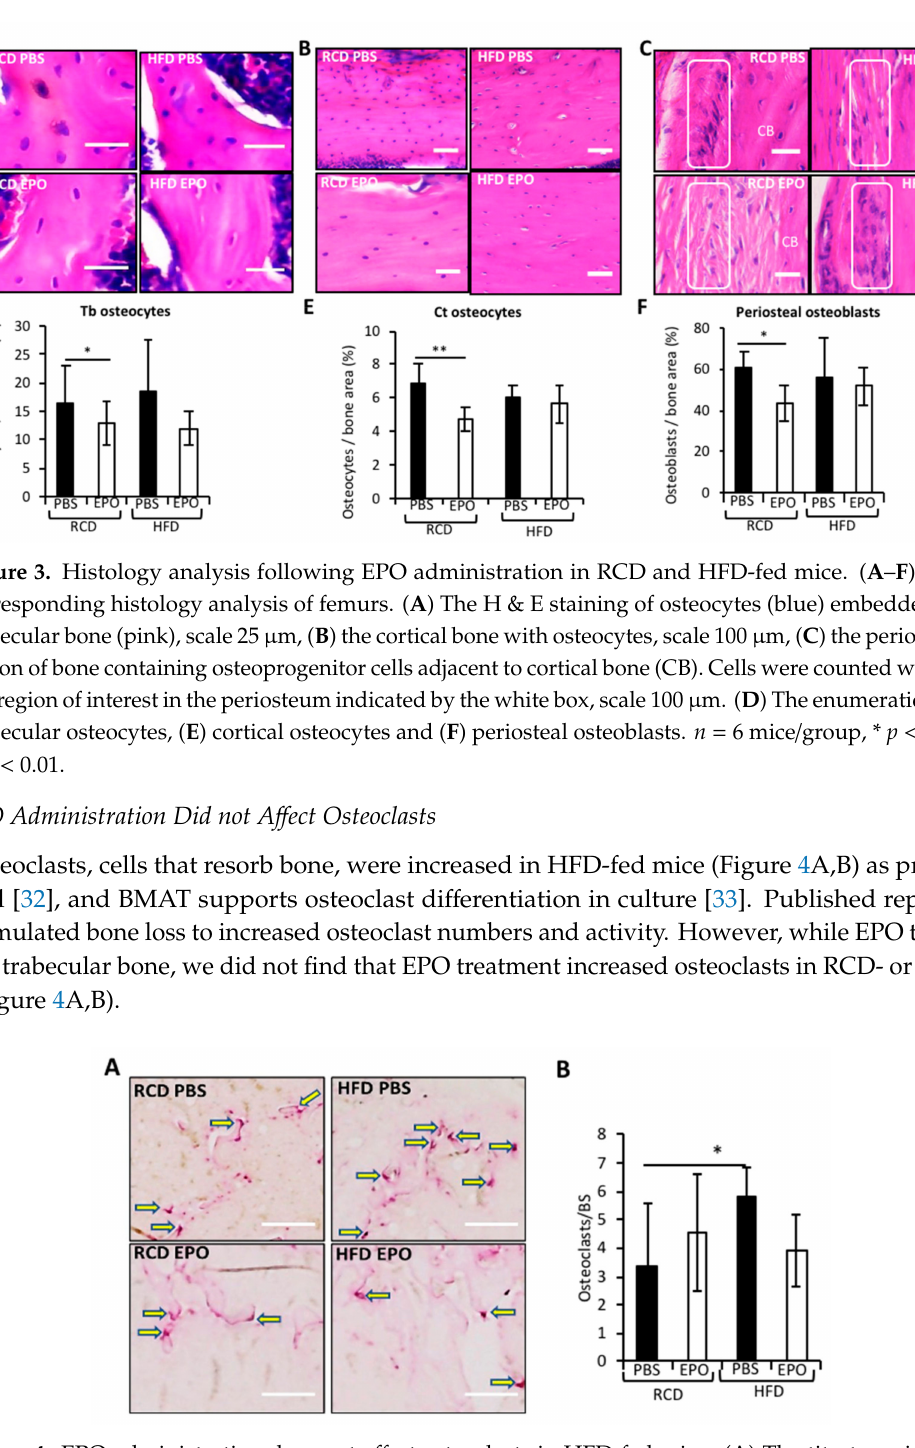
Figure 4. EPO administration does not a ff ect osteoclasts in HFD-fed mice. ( A ) The titrate-resistant acid phosphatase (TRAP) staining of femurs showing osteoclasts with adjacent arrows, scale 50 µ m, arrows indicate purple-colored osteoclasts. ( B ) The enumeration of osteoclasts per bone surface (BS) ( n = 6 / group), * p <